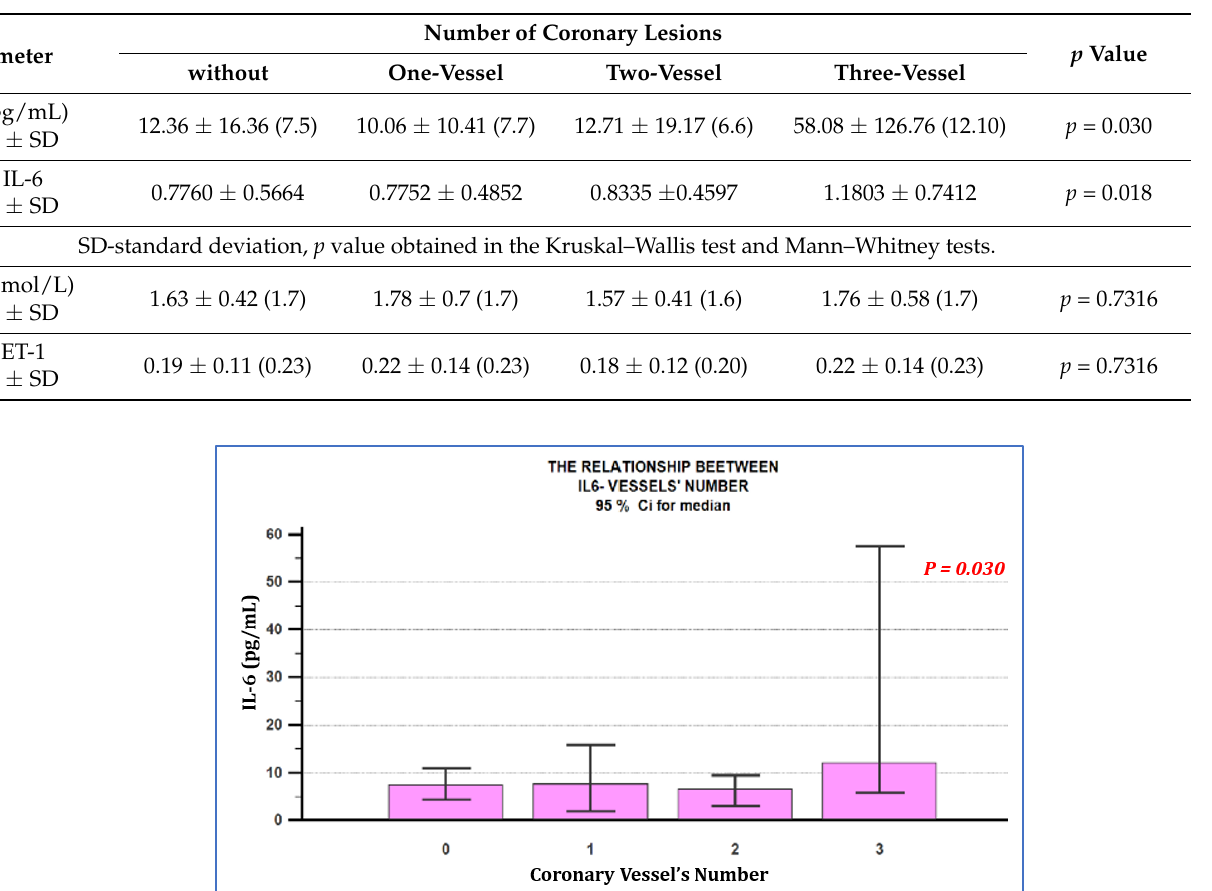
Figure 1. Relationship between the serum IL-6 value and the number of affected coronary vessels. IL-6 levels were similar in the group of patients with microvascular angina, one and two-vessel coronary artery disease, but statistically significantly higher among patients with three-vessel coronary lesions ( p = 0.030). 0 — microvascular angina; 1 — one-vessel coronary disease; 2 — two-vessel coronary disease; 3 — three-vessel coronary disease.